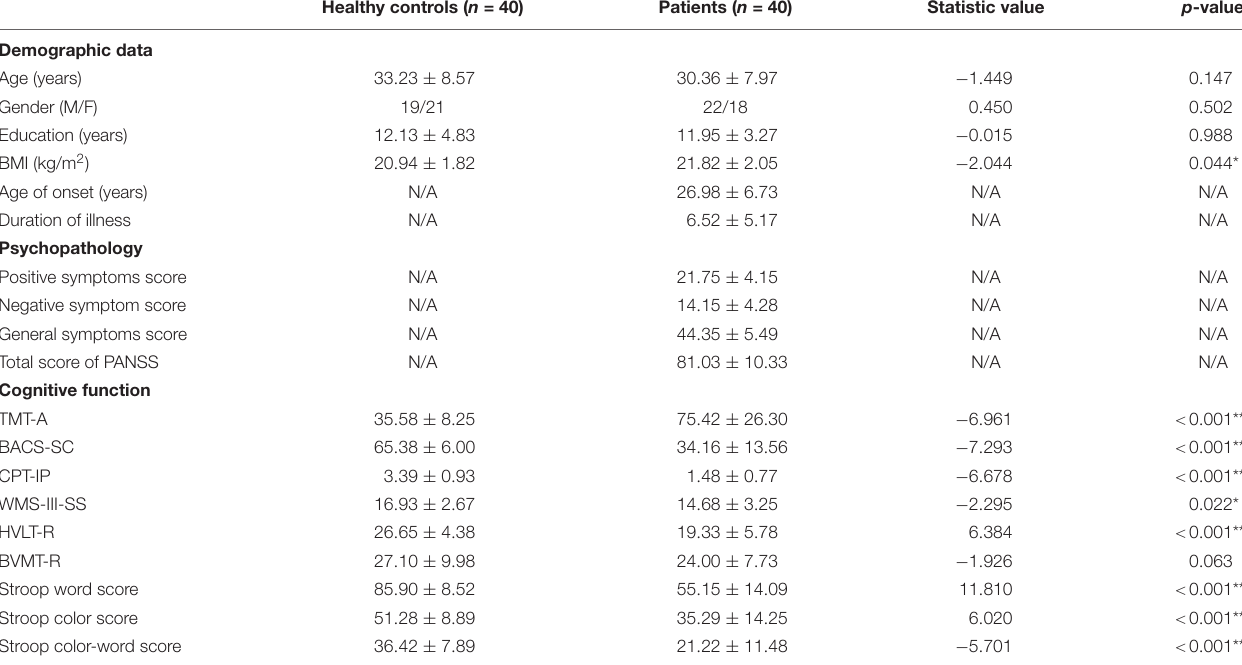
TABLE 1 | Comparisons of demographic data, psychopathology and cognition between healthy controls and patients with schizophrenia. Healthy controls ( n = 40) Patients ( n = 40) Statistic value